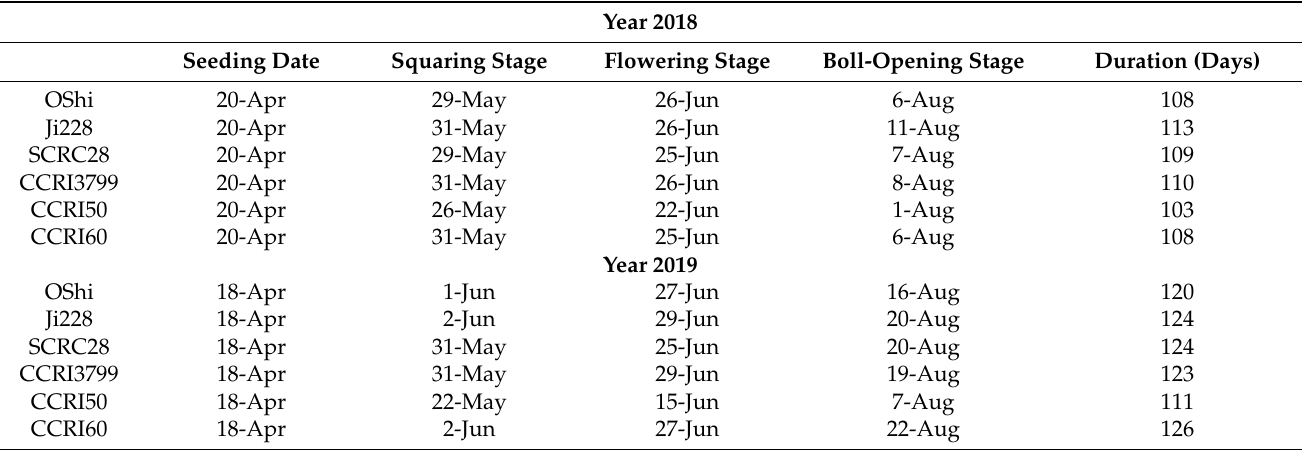
Table 1. Date of different growth stages of six cultivars in 2018 and